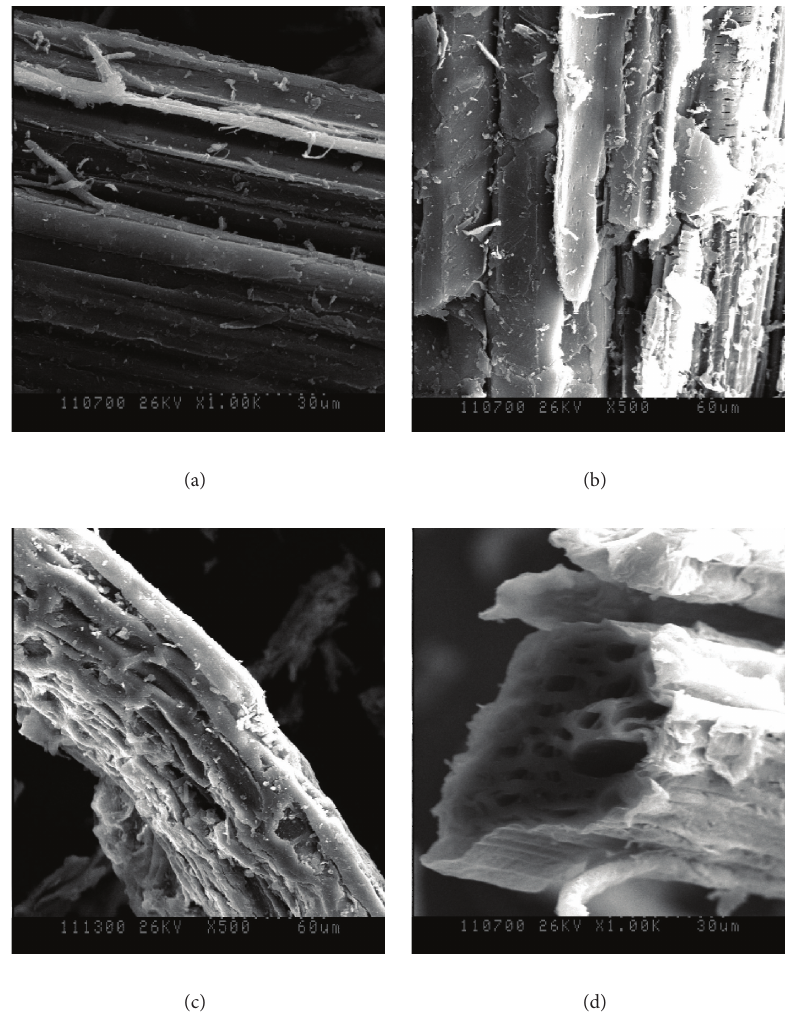
Figure 2: SEM micrographs of (a) PA sample, (b) BC-400-0 sample, and (c and d) BC-400-0.5 sample.